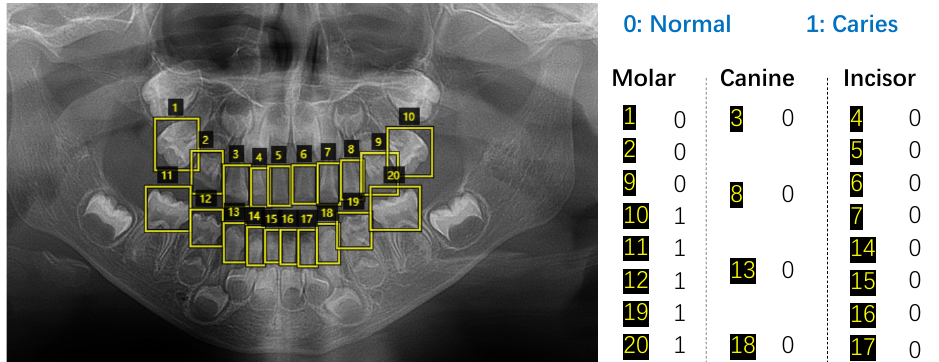
Figure 1. Extracting and labeling each tooth on a panoramic